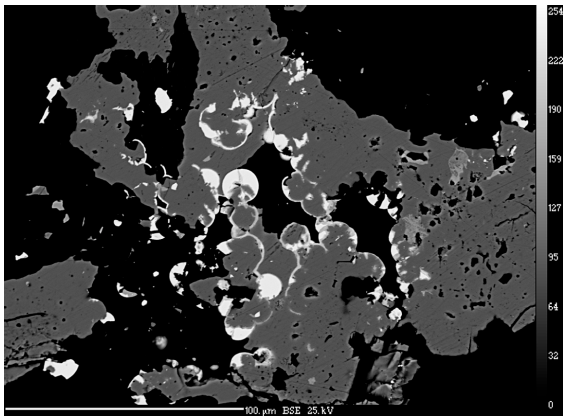
Figure 33. Eskebornite aggregates (dark grey) partly replace earlier spherical aggregates of uraninite (white). BSE photograph. P ř íbram, a dump of shaft 16. Photo by J. Sejkora, P. Škácha. In reflected light, eskebornite is light brown with a pink shade. It is strongly anisotropic under crossed polarizers.